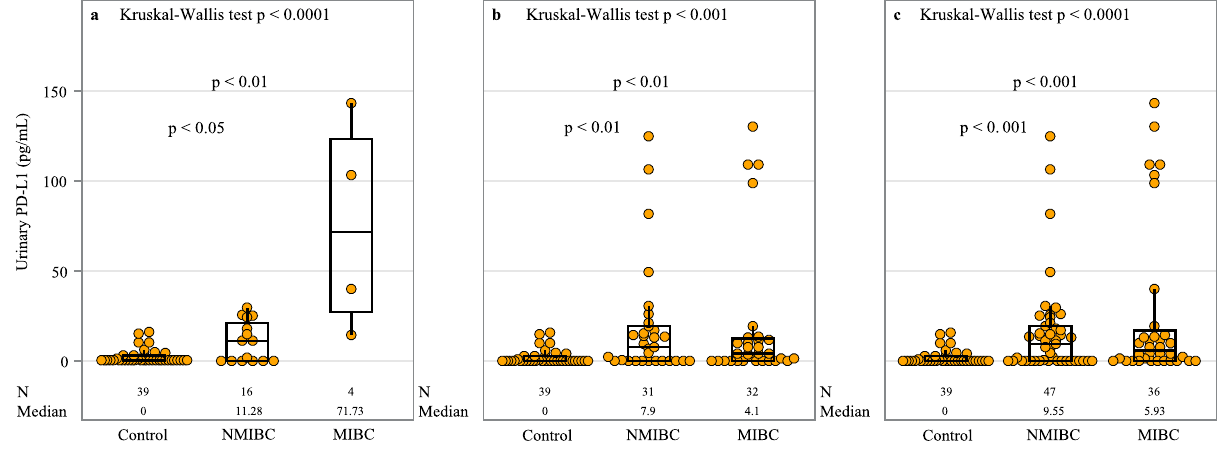
Figure 1. Distribution of PD-L1 concentration in controls and NMIBC and MIBC sub-groups. Patients with BCa are sampled from: ( a ) group 1 (before TURB), ( b ) group 2 (after TURB) and ( c ) combined groups 1 and 2. Results are presented by a box plot, with each dot representing one patient. An extreme outlier of 487.5 pg/ mL in the MIBC sub-group in ( b ) and ( c ) is not shown on the plot. Analysis of urinary PD-L1 concentrations demonstrated departure from Gaussian distribution using Shapiro–Wilk test in all groups. Non-parametric Kruskal–Wallis test was thus used to determine if there was significant variation in the medians of the groups analyzed. If significant at the 5% level, we then used Dunn’s multiple comparison post-hoc test to investigate pair-wise group comparisons of urinary PD-L1. This testing procedure was followed in ( a–c ). Only